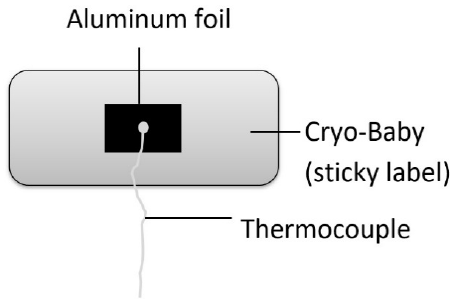
Figure 1. Polyether ether ketone (PEEK) rack, ( a ) top side, ( b ) cross section, ( c ) tub with nested vials from Schott, AdaptiQ.